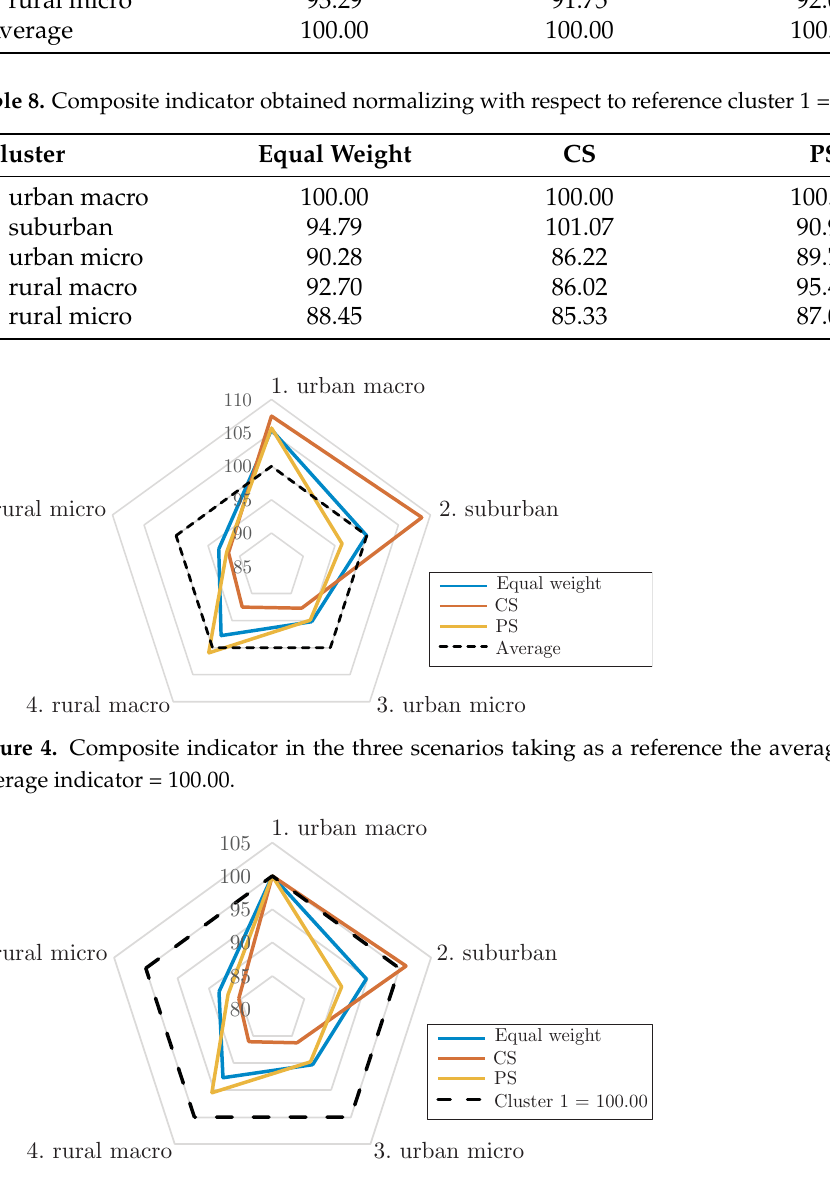
Figure 5. Composite indicator in the three scenarios taking as a reference cluster 1. Cluster 1 =